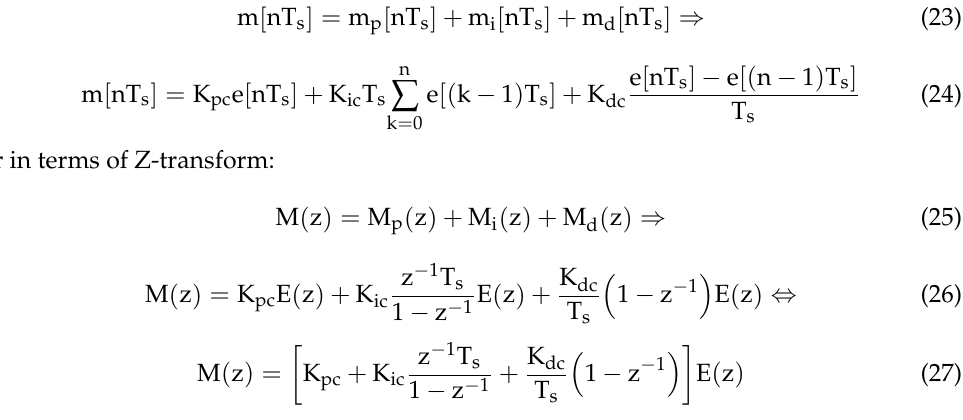
Figure 11. Digital D-term block diagram.